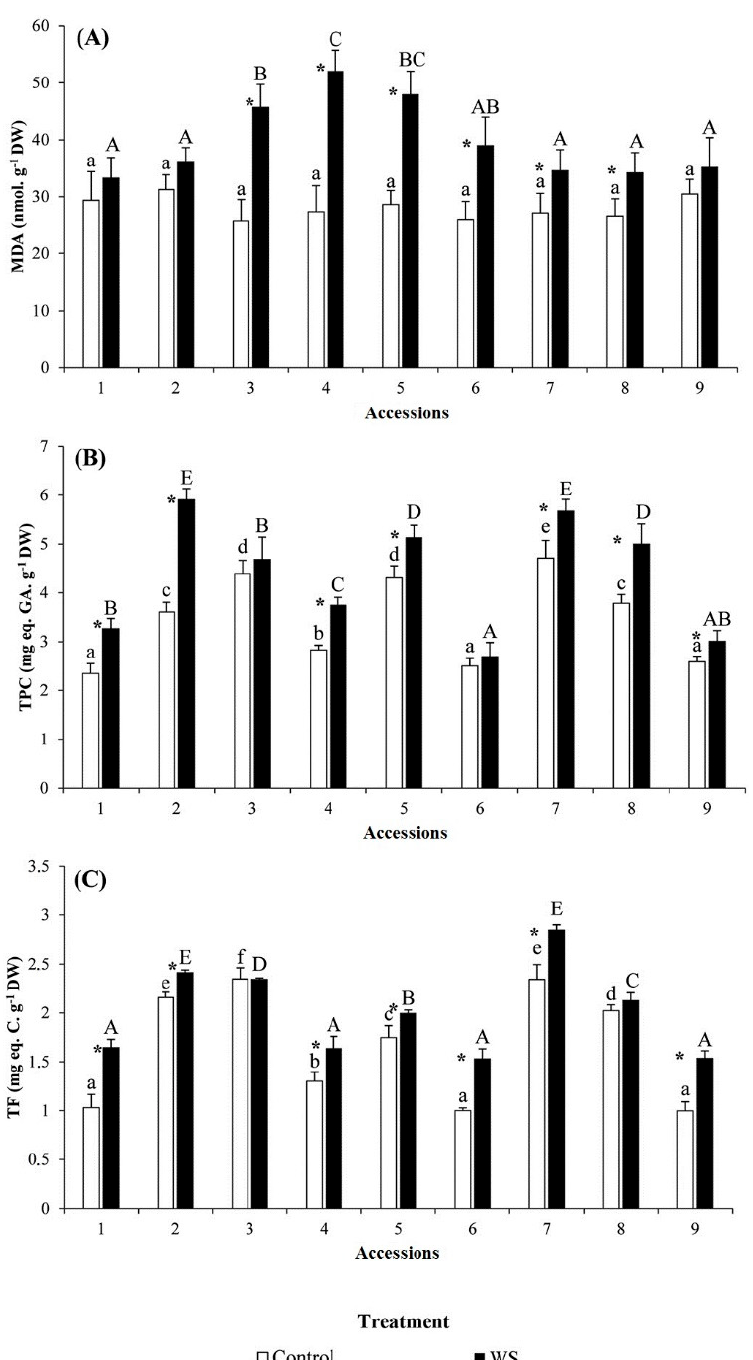
Figure 4. Variation in oxidative stress biomarker and chemical antioxidants concentrations in the nine Ardhaoui landrace accessions of barley after three weeks of water stress (WS) treatment: ( A ) malondialdehyde (MDA); ( B ) total phenolic compounds (TPC); and ( C ) total anti-oxidative flavonoids (TF). Error bars indicate SE. For each accession, asterisks (*) indicate significant differences between control and WS treatments and different letters indicate significant differences among accessions undergoing the same treatment, according to the Tukey test ( α = 0.05).